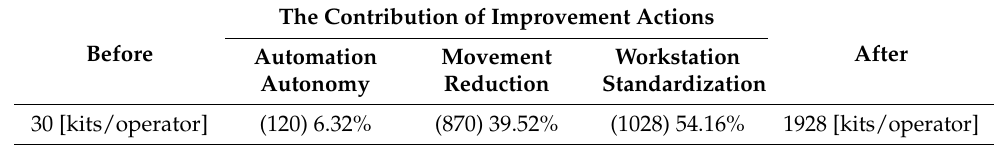
Table 2. Capacity production evolution.